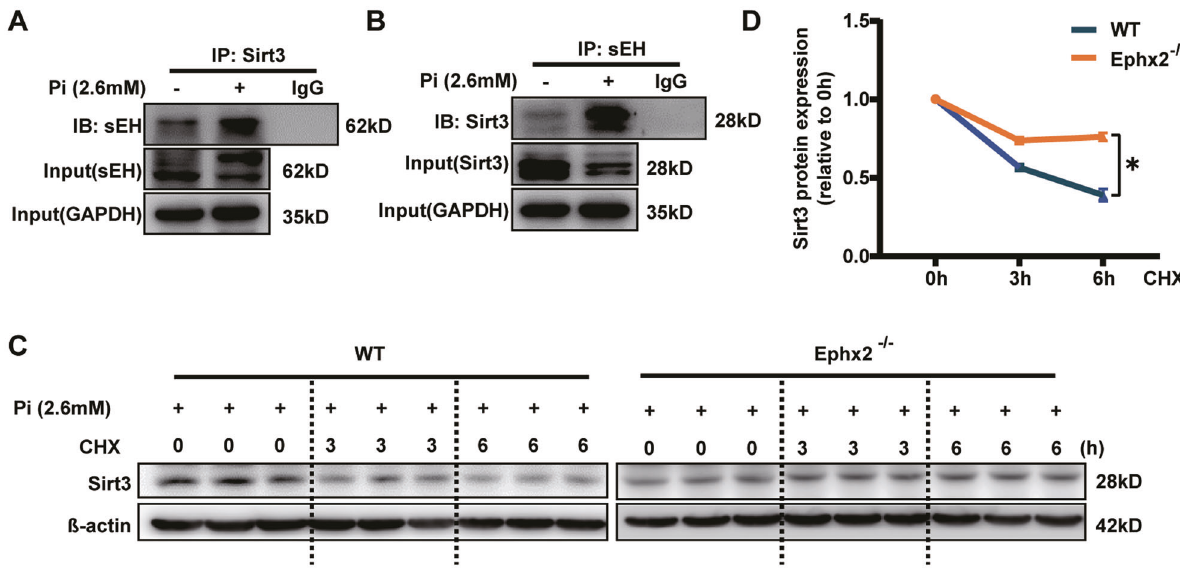
Fig. 4 Soluble epoxide hydrolase (sEH) affected the degradation of Sirtuin 3 (Sirt3). A , B High phosphate (Pi) triggered the combination of sEH and Sirt3. Cellular lysates were immunoprecipitated (IP) with anti-sEH antibody and then immunoblotted (IB) with anti-Sirt3 ( A ), or IP with anti-Sirt3 antibody and then IB with anti-sEH ( B ). C , D High Pi treatment markedly accelerated Sirt3 degradation in wild-type (WT) compared with Ephx2 − / − VSMCs. CHX indicates cycloheximide. Data are presented as mean ± SD. * P < 0.05 vs. WT 6 h. Data are presented as mean ± SD. * P <